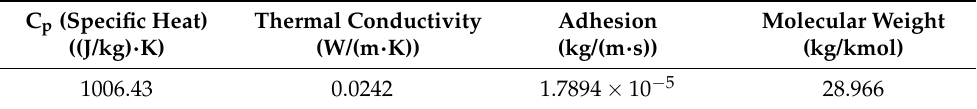
Table 1. Gas properties of ideal gas filling air domain at 20 °C.